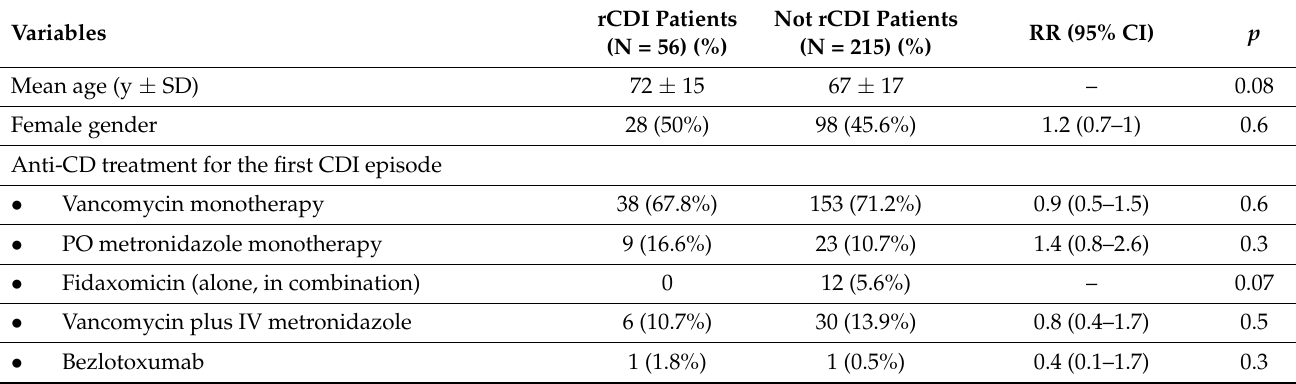
Table 4. Risk factors for the occurrence of rCDI. Univariate analysis. RR: risk ratio. CI: confidence interval. SD: standard deviation. rCDI: recurrent Clostridioides difficile infection. PO: per os. IV: intravenous administration.